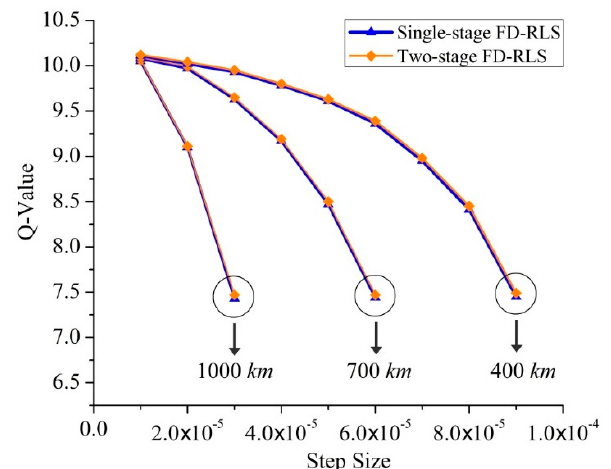
Figure 28. The Q-value vs. step size using both two-stage and single-stage FD-RLS algorithms as a function of transmission distance in an FMF-based transmission system [15].